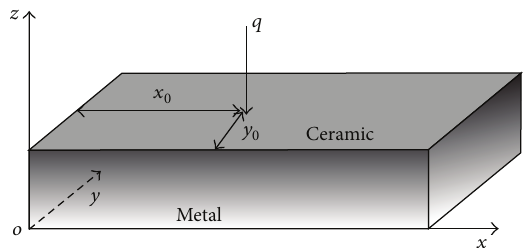
Figure 2: FGM plate subjected to point